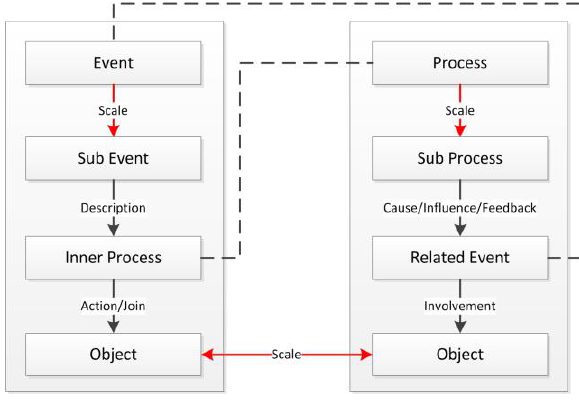
Figure 4. Semantic enrichment method for